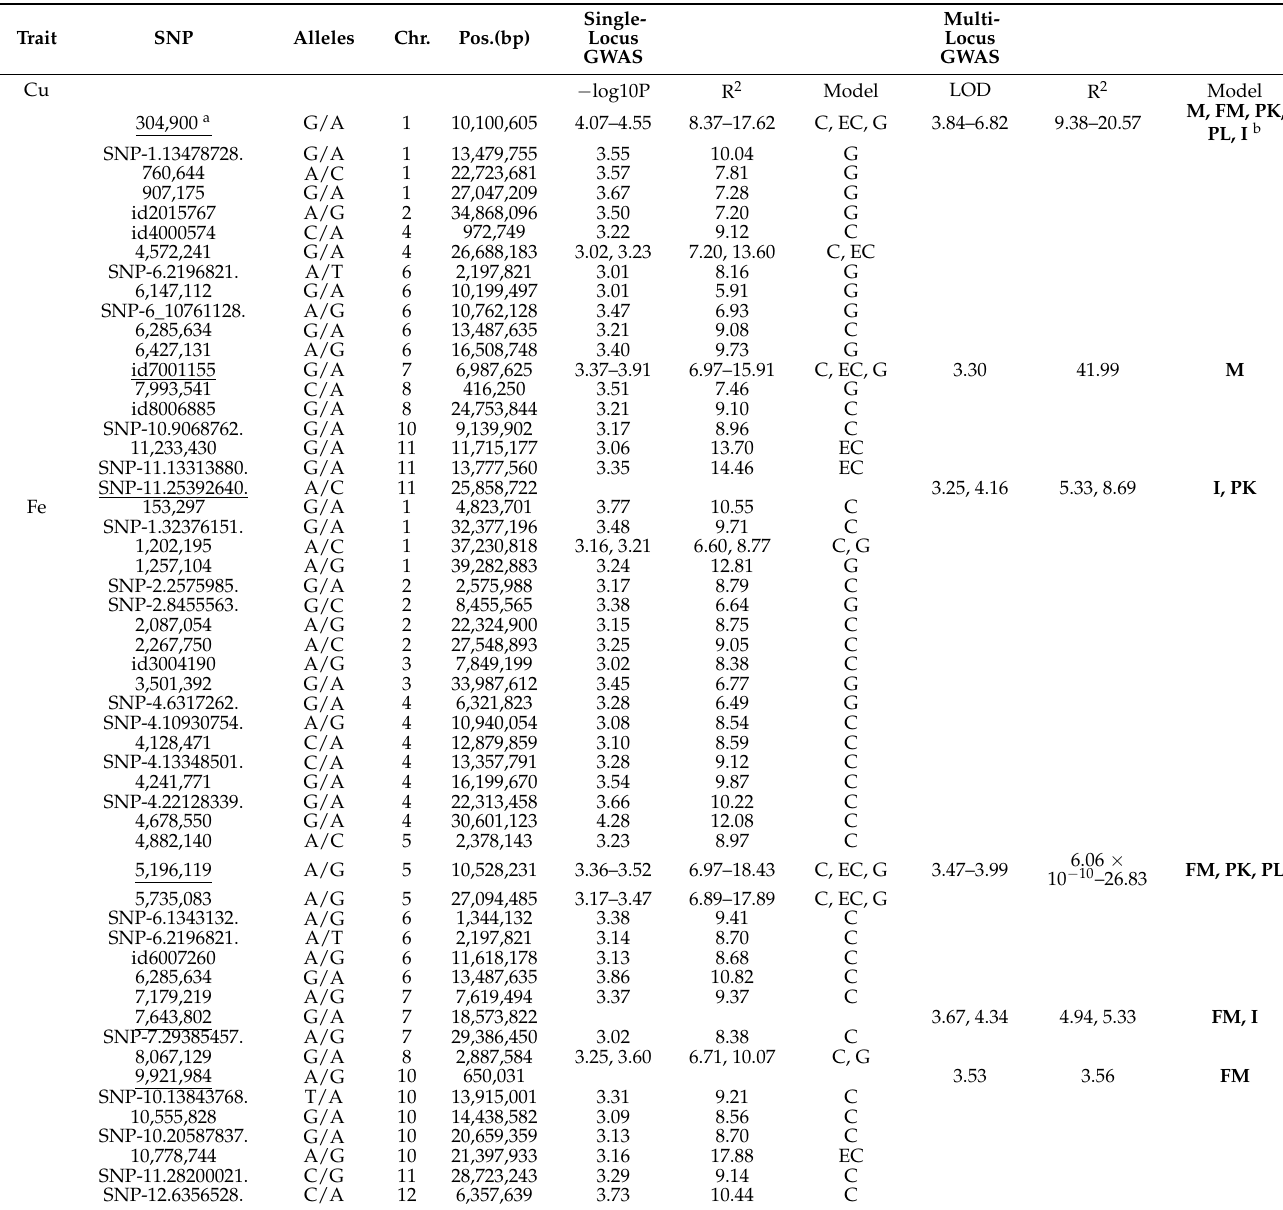
Table 2. List of significant loci detected in the study at − log 10 P ≥ 3.0 and 15% FDR cut-off value for Single-locus GWAS, and LOD ≥ 3.0 cut-off value for Multi-locus